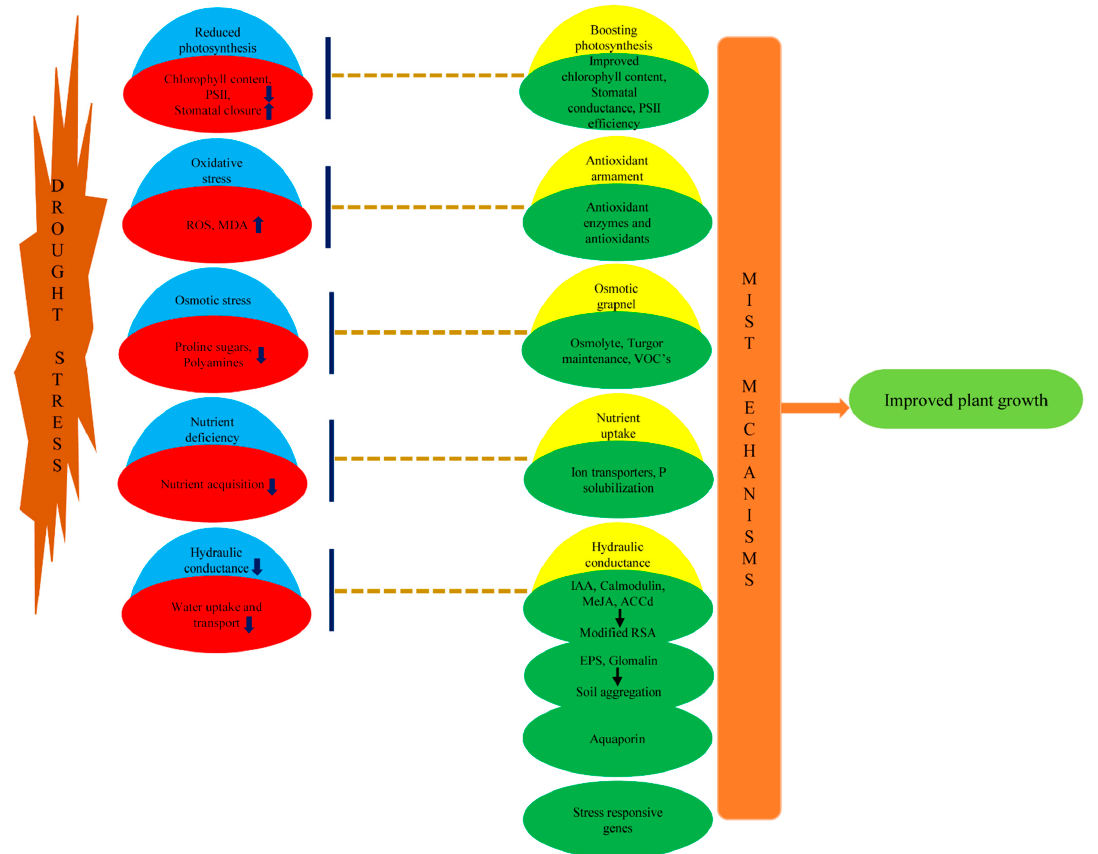
Figure 1. On the left side drought stress negatively impacting plant growth by secondary osmotic, oxidative stresses, reduced photosynthesis, hydraulic and nutrient conductivity. On the right side major microbial induced systemic tolerance (MIST) mechanisms displayed by microbes enhancing plant growth during drought stress.